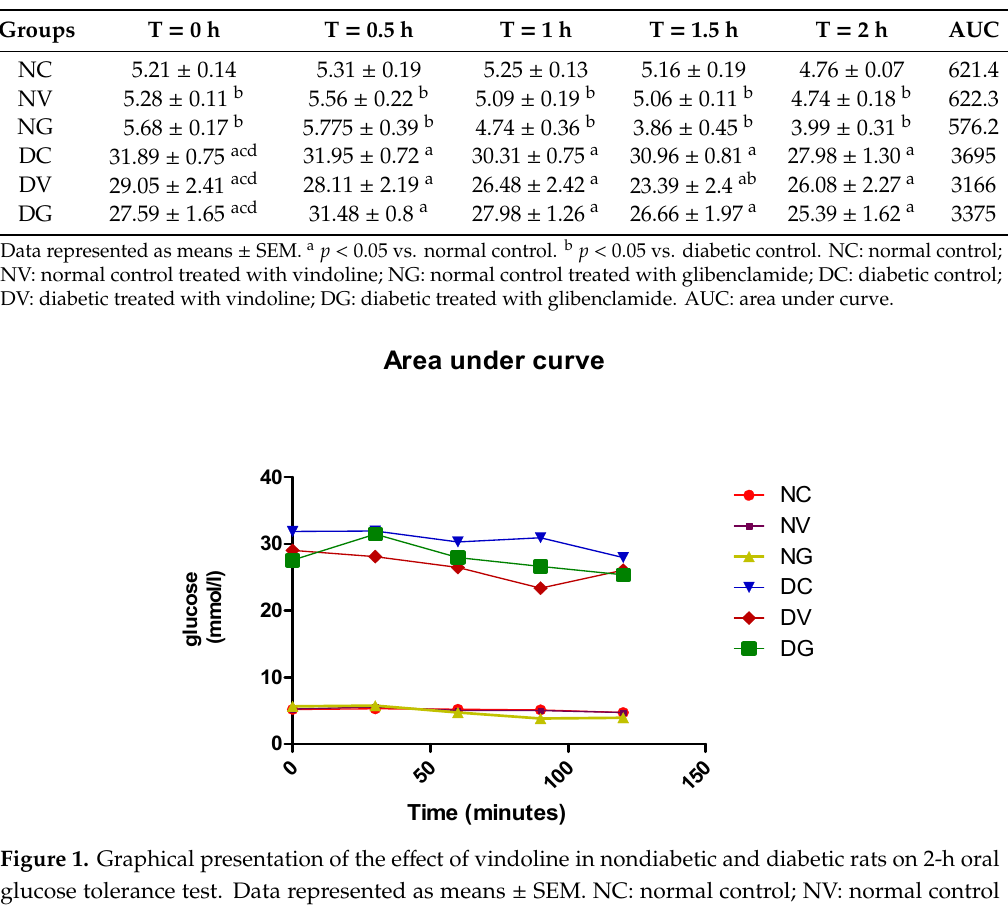
Table 1. E ff ect of vindoline in nondiabetic and diabetic rats on 2-h oral glucose tolerance test.